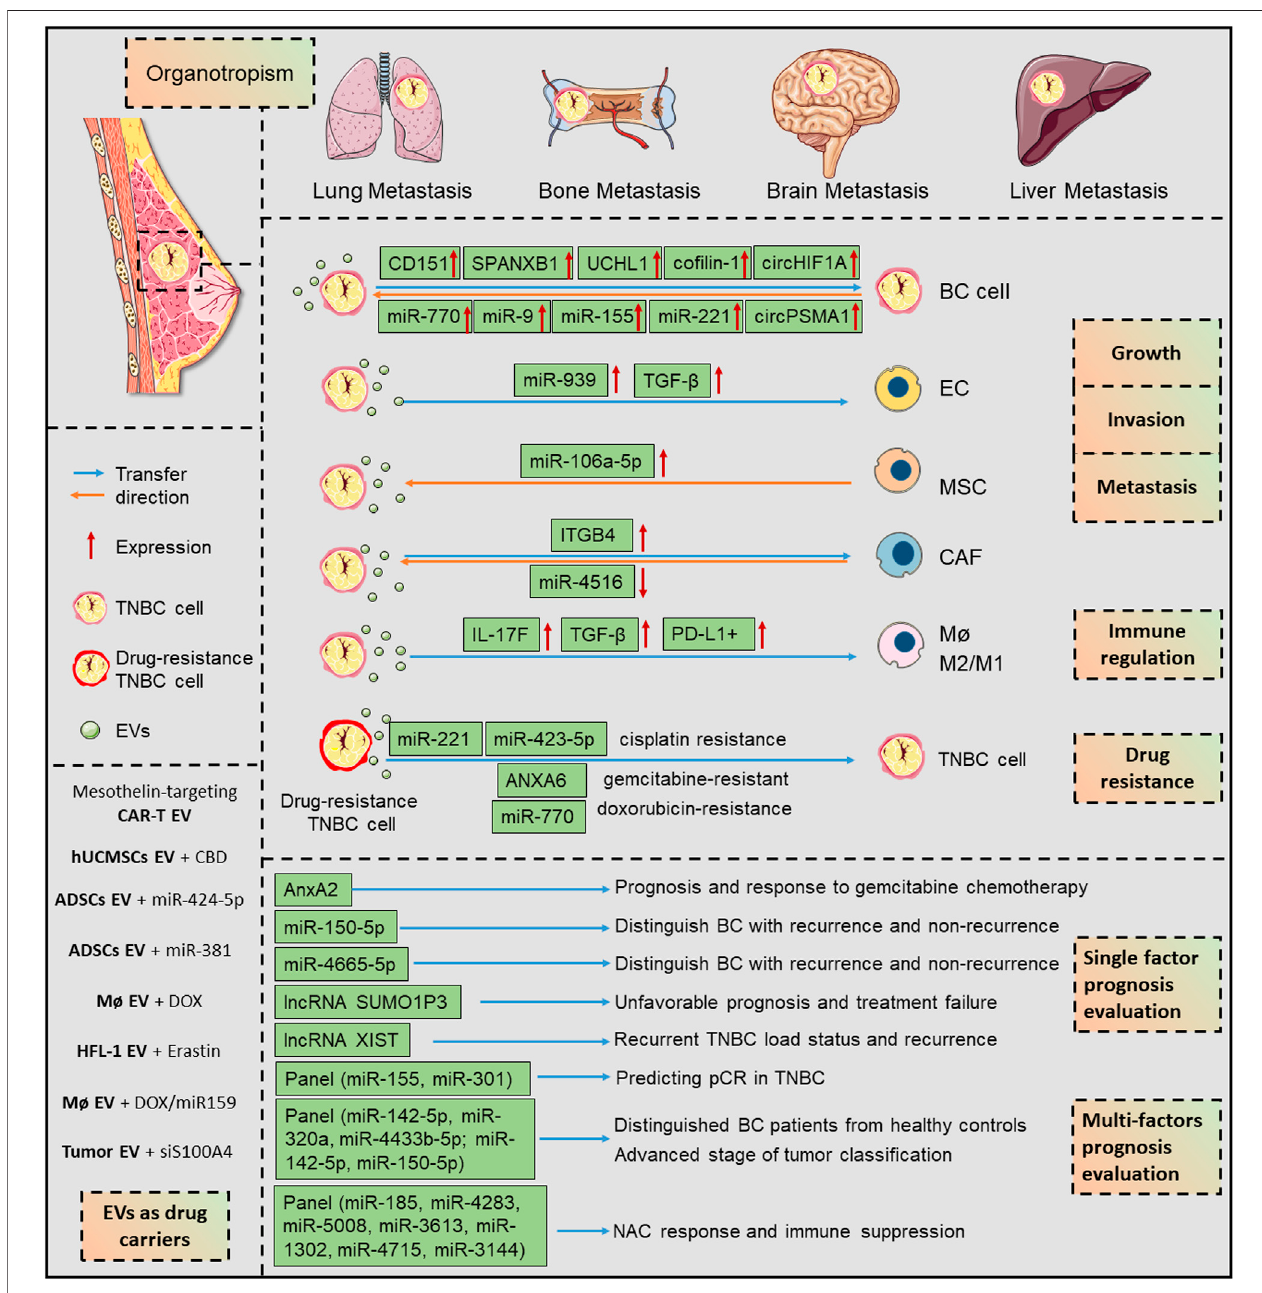
FIGURE2| The EV-associated mechanisms in TNBC progression and their potential applicationsin diagnosisand treatment. EVs evoke numerous pathwaysthat are intensively associated with growth, invasion, and metastasis, during their bidirectional interactions with multiple cell types in tumor environment. The horizontal transferofEVcargoes,representedbyprotein,miRNA,lncRNA,circRNA,aredepictedasimportantorchestratorsinshapingtheTNBCprogression.Besides,EVsareas promising biomarkers for TNBC state, prognosis, and therapeutic effect evaluation. Due to their stable carrier properties, EVs are promising engineered nano- carriers for encapsulating biological compounds for TNBC therapy. ANXA6, annexin A6; BC, breast cancer; CAF, cancer-associated fi broblasts; CAR-T, chimeric antigen receptor T cell; CBD, cannabidiol; DOX, doxorubicin; EC, endothelial cell; EV, extracellular vesicle; ITGB4, integrin β 4; lncRNA, long non-coding RNA; M2/M1, alternative anti-in fl ammatory activation (M2), pro-in fl ammatory activation (M1) and; Mø, macrophage; MSC, mesenchymal stromal cells; NAC, neoadjuvant chemotherapy; pCR, pathological complete response; TNBC, triple-negative breast cancer.